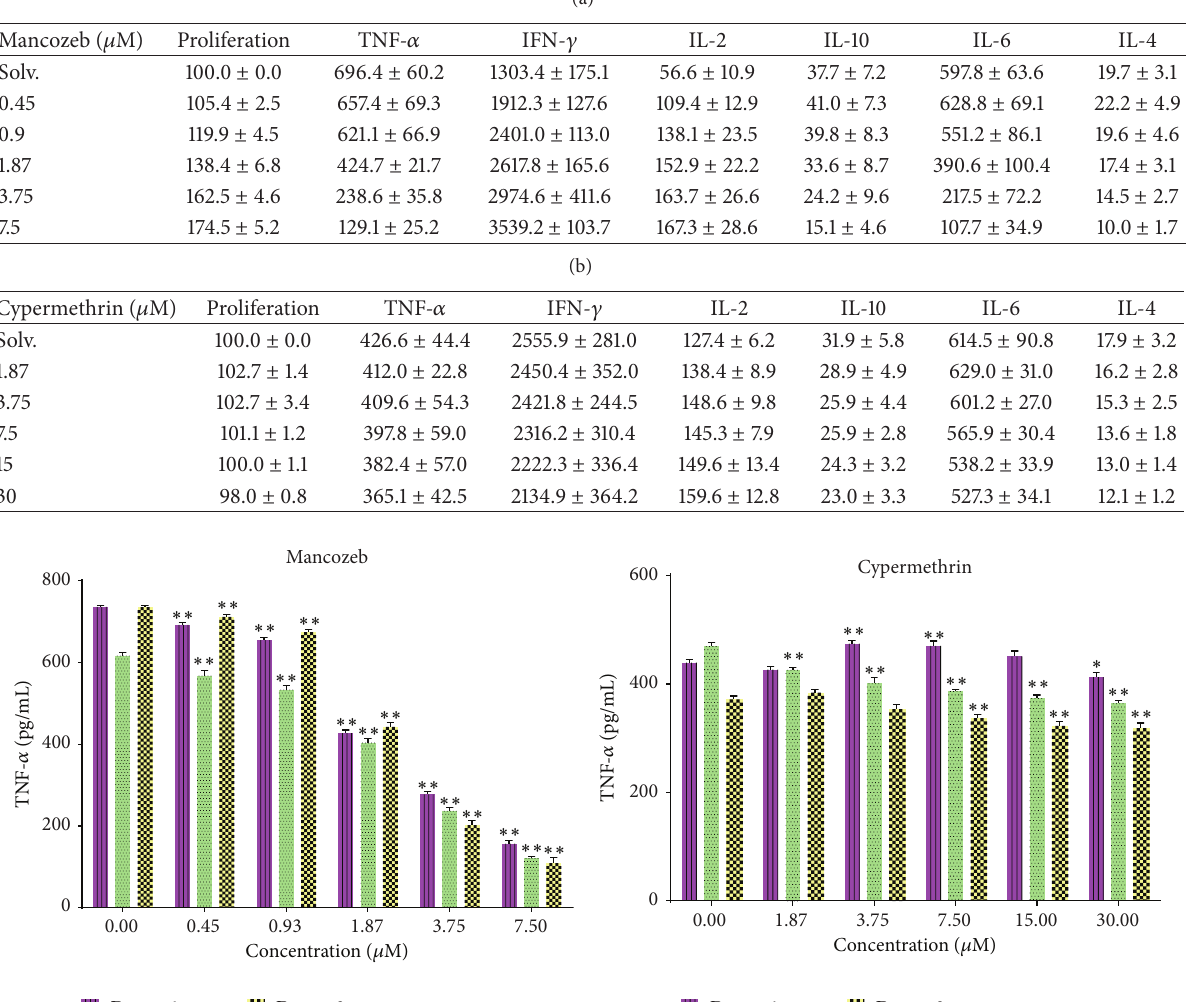
1 /T 2 cytokine production (pg/mL) in PBMC cultures. Values shown are average ± H H